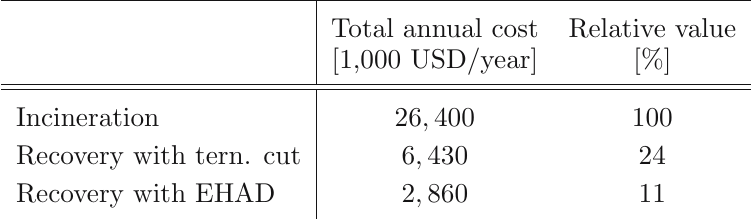
Table 5 Total annual costs of the waste solvent treatment